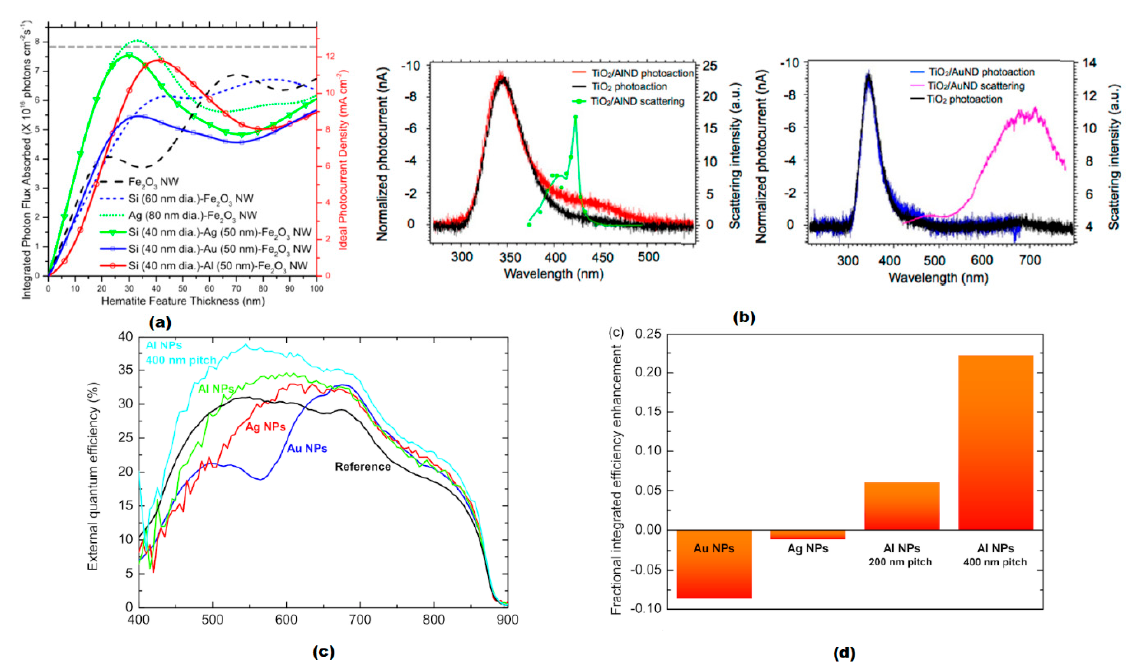
Figure 6. ( a ) Integrated absorbed photon flux and Ideal photocurrent density of Fe 2 O 3 , Si-Fe 2 O 3 and Si-Metal-Fe 2 O 3 core-shell nanowires. Reproduced with permission from [37]. Copyright American Chemical Society, 2016. ( b ) Photocurrent and scattering spectrum of TiO 2 thin films with or without Al or Au nanodimers. Reproduced with permission from [38]. Copyright American Chemical Society, 2016. ( c ) Experimental photocurrent spectra and ( d ) Integrated EQE enhancement provided by different nanoparticle (Au, Ag, Al) arrays